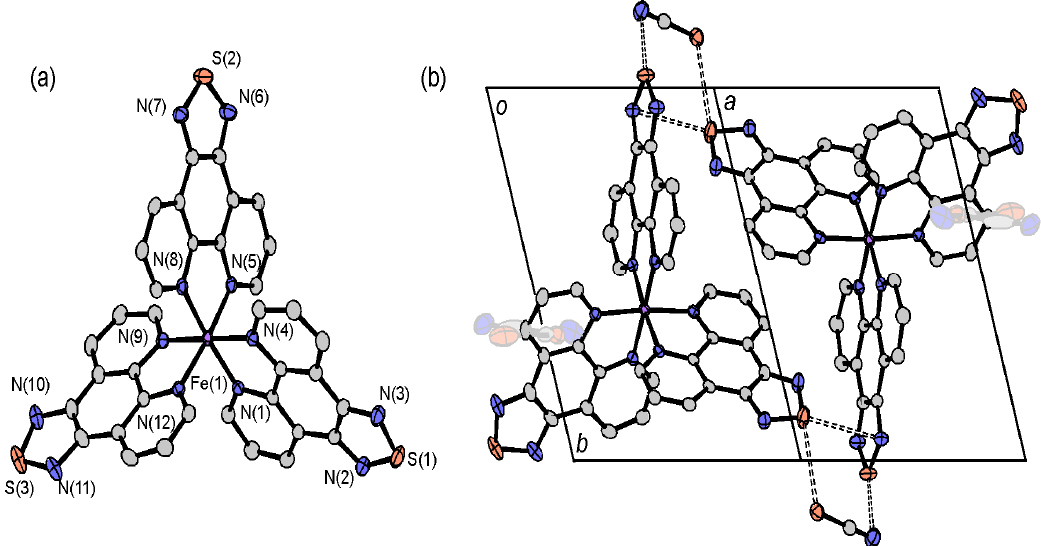
Figure 10. Molecular structure and crystal structure of [Fe(tdap) permission of The Royal Society of